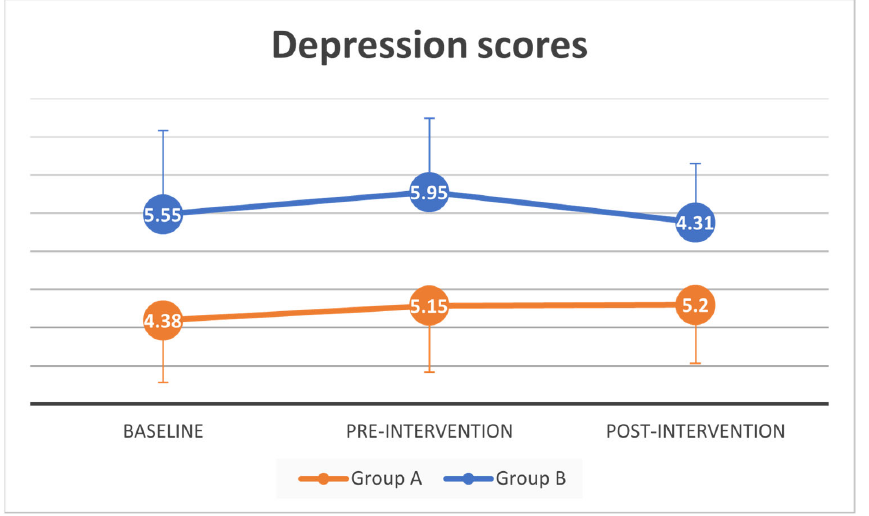
Figure 4. Depression scores at baseline, pre and post